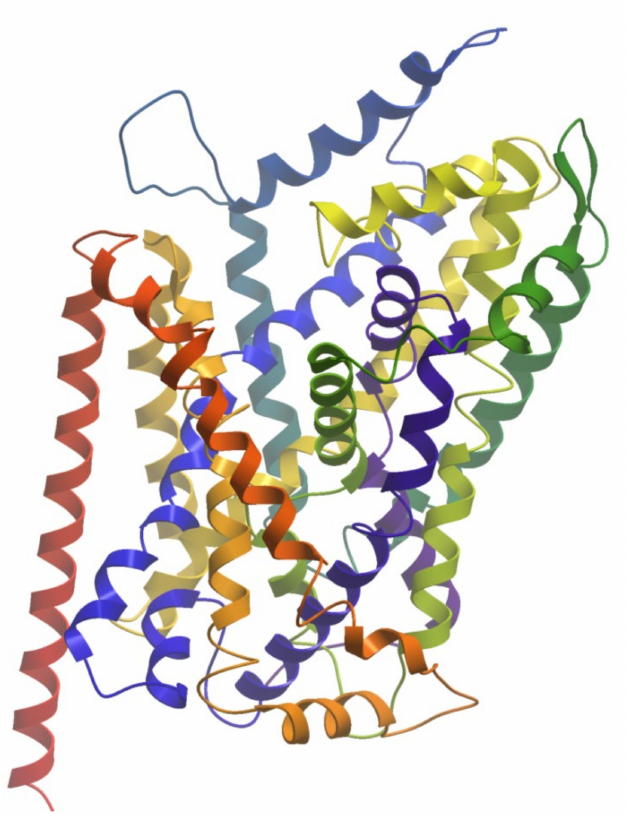
Figure 2. The structure of leucine transporter (PDB ID: 2A65). The helices are colored from N- terminus (blue) to C-terminus